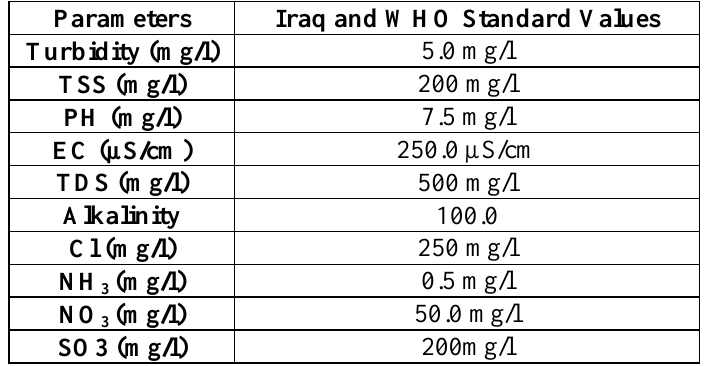
Table 3: Iraq and WHO standard values of water quality